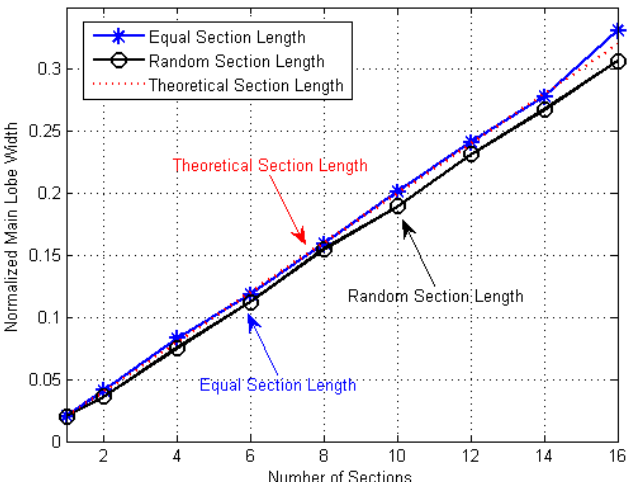
Figure 13. Relationship between number of sections and main lobe width.